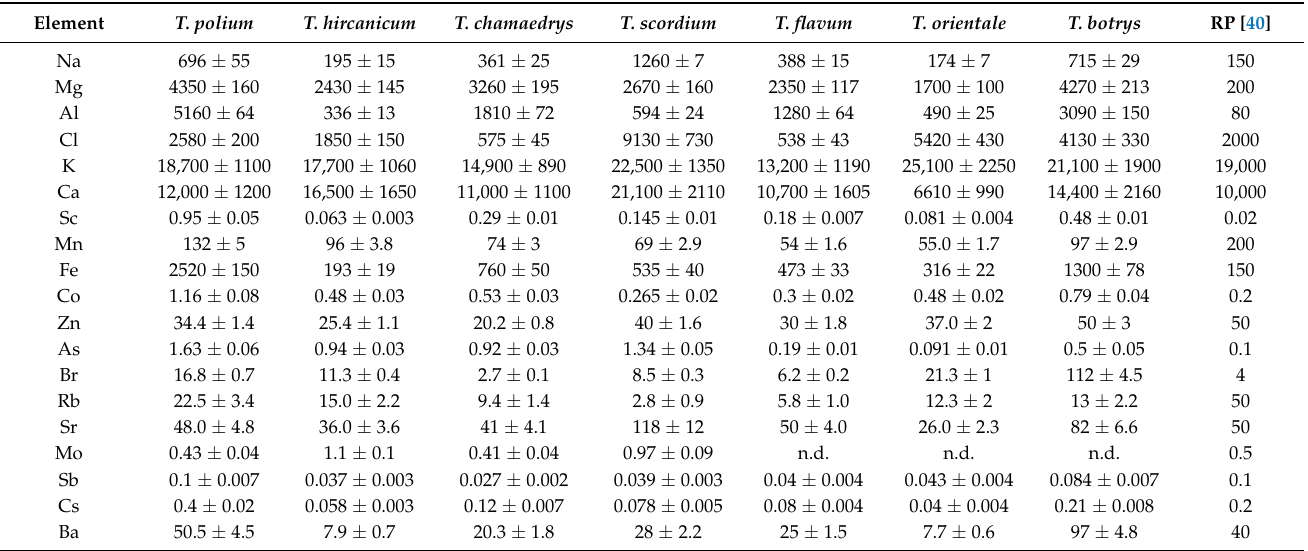
Table 2. Elemental content (mean of three measurements ± SD) of analyzed samples determined by NAA (in mg/kg), as well as reference plant values